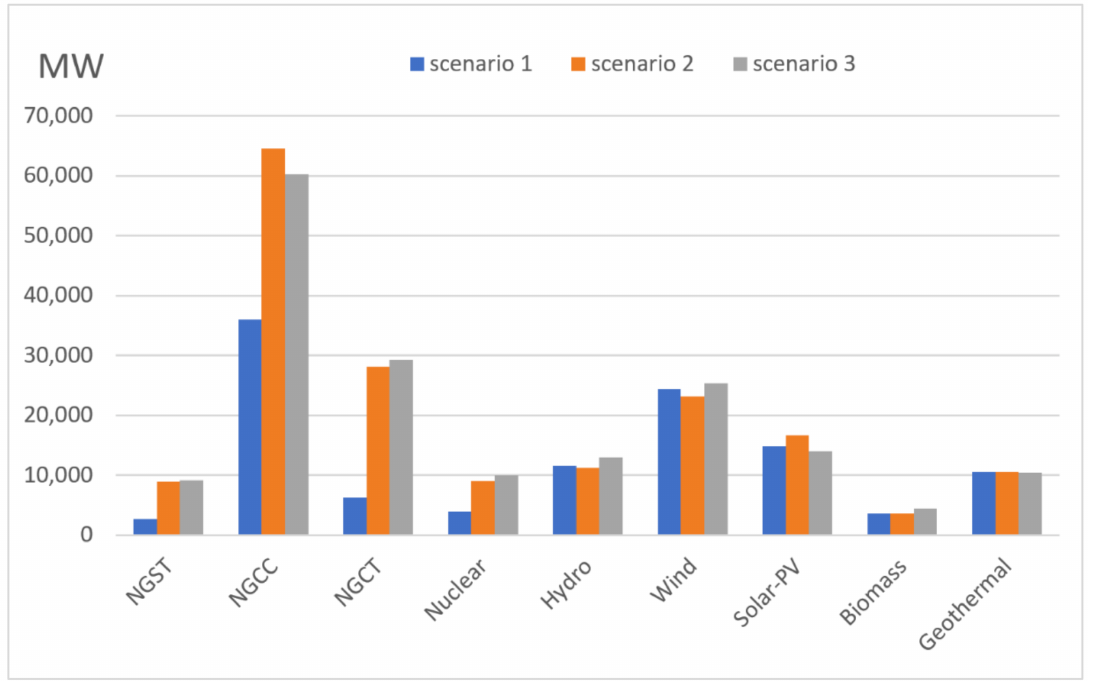
Figure 6. The profit of each power plant in strategy 2 and 3 in million dollars.